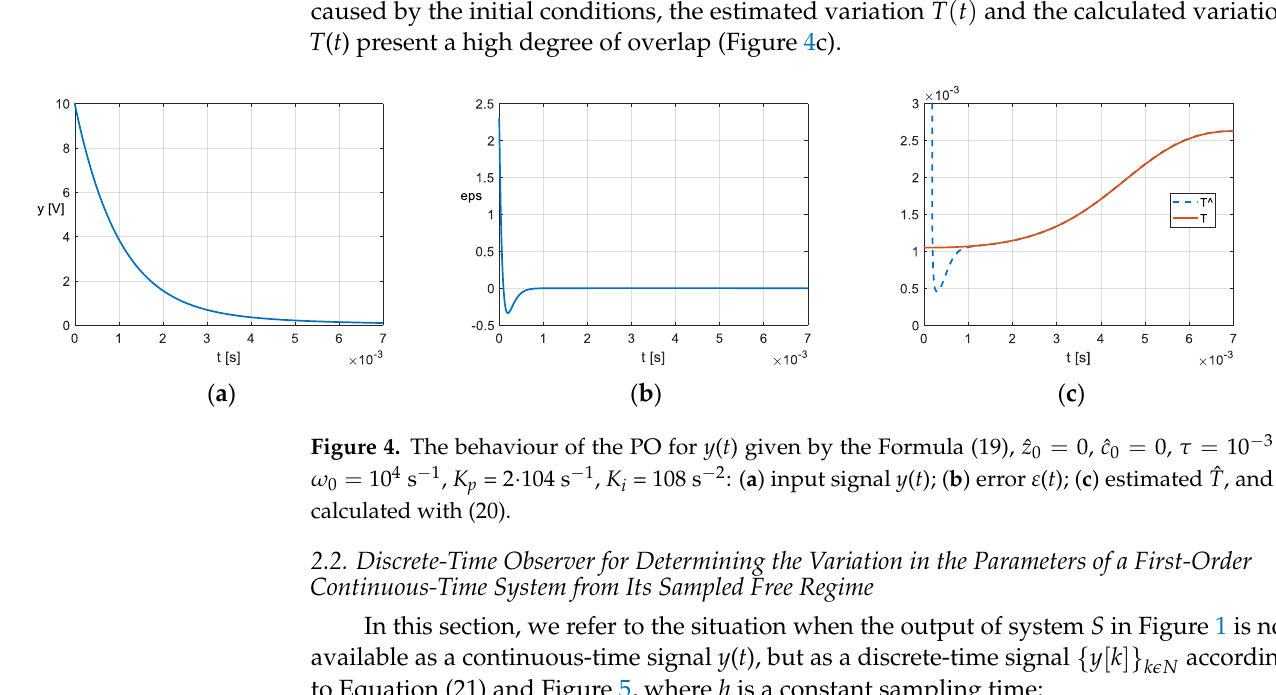
Figure 4. The behaviour of the PO for y ( t ) given by the Formula (19), 𝑧̂ 𝑜 = 0 , 𝑐̂ 𝑜 = 0 , 𝜏 = 10 −3 s , 𝜔 𝑜 = 10 4 s −1 , K p = 2  104 s −1 , K i = 108 s −2 : ( a ) input signal y ( t ); ( b ) error  ( t ); ( c ) estimated T ^, and T calculated with (20).